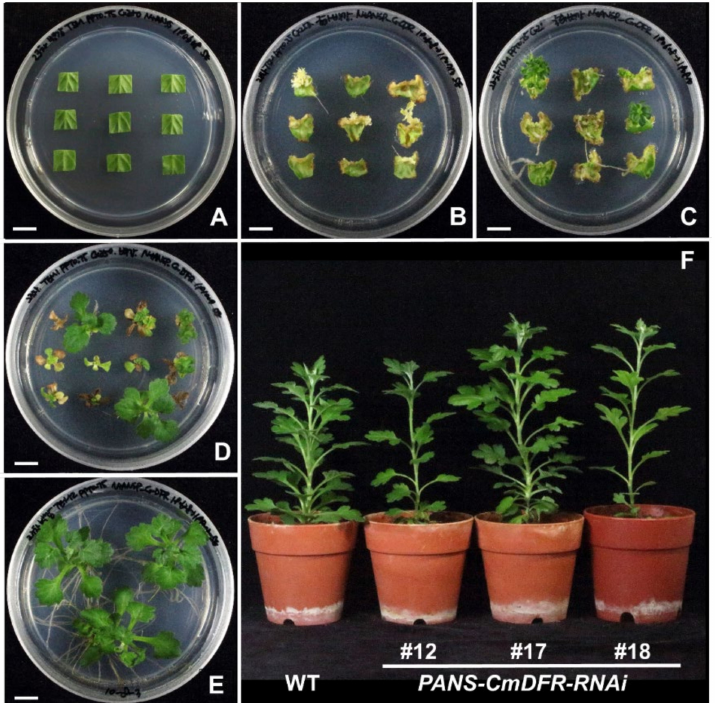
Figure 2. Agrobacterium -mediated transformation and regeneration of transgenic plants of chrysanthe- mum ‘Baekgang’. Leaf segments were inoculated with Agrobacterium harboring PANS-CmDFR-RNAi ( A ). After 5 weeks of culture in the dark, etiolated shoots were regenerated from explants ( B ); after 4 weeks under 16-h light/8-h dark photoperiod, etiolated shoots turned green ( C ). After 12–16 weeks of cultivation with PPT, a few shoots survived and developed ( D ). Surviving shoots were transferred into root-inducing medium with PPT ( E ). Plantlets were acclimatized and developed into normal plants ( F ). Bar = 1